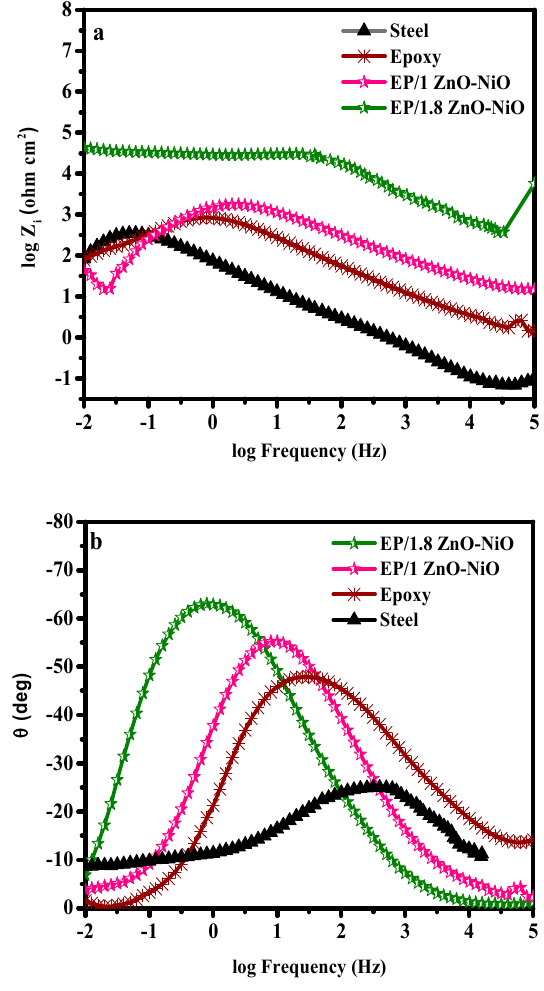
Figure 5. ( a , b ) Bode plots acquired for steel, epoxy and EP / 1.0 ZnO-NiO nanocomposite coated mild steel immersed in 3.5% NaCl solution.